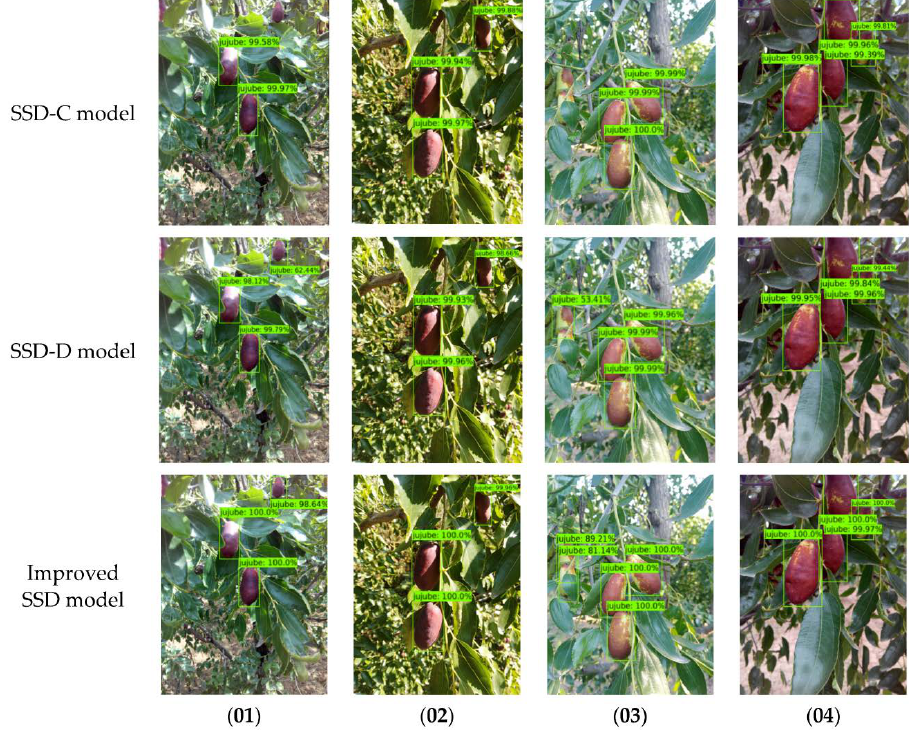
Figure 14. Improved SSD model structure comparison laboratory outcomes. ( 01–04 ) The detection outcomes of the three models. Table 3. Results of the comparison experimental evaluation indicators of the improved SSD model